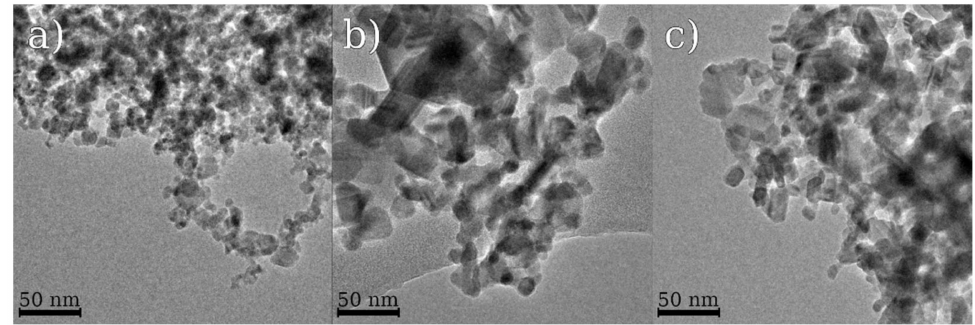
Figure 2. TEM images of samples: ( a ) Ga 2 O 3 /Nb-0-500; ( b ) Ga 2 O 3 /Nb-0-900; ( c ) Ga 2 O 3